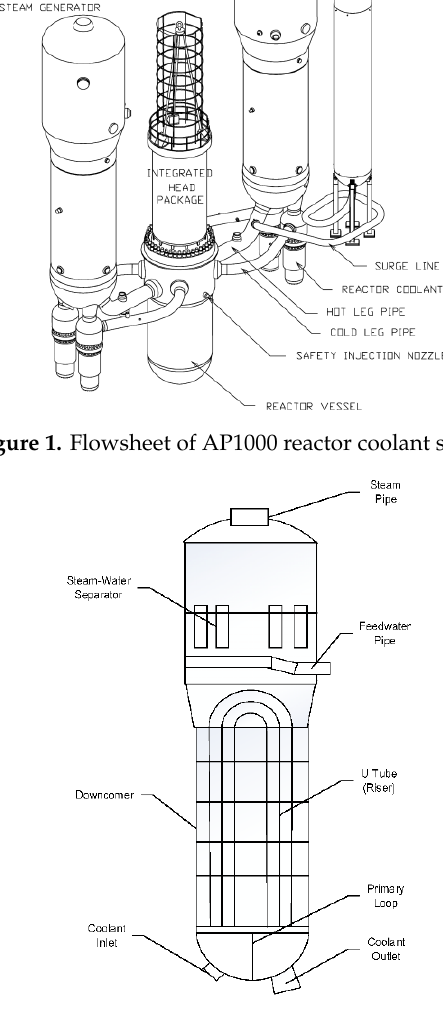
Figure 2. Flowsheet of steam generator.